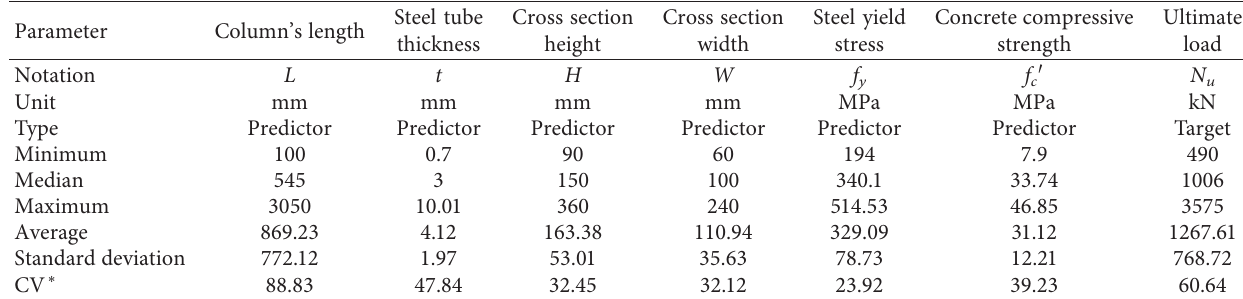
Table 2: Initial statistical analysis of variables in the